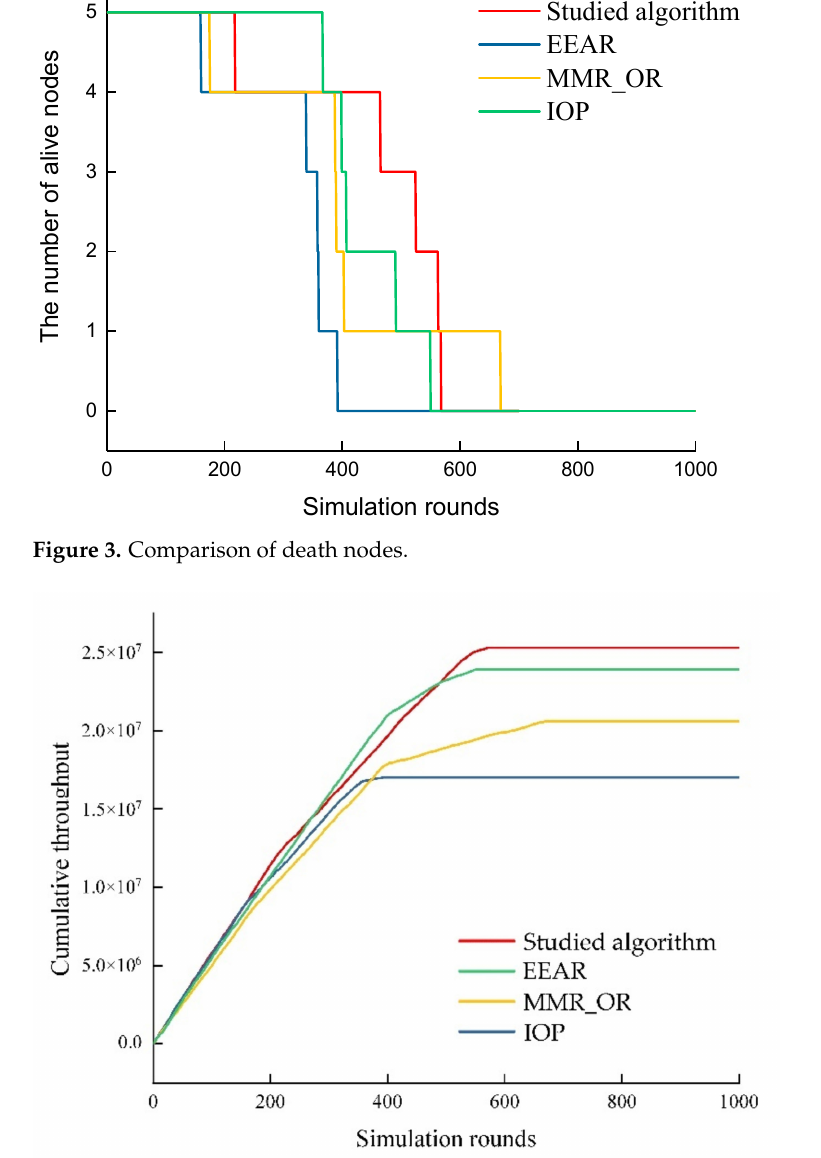
Figure 4. Comparison of cumulative